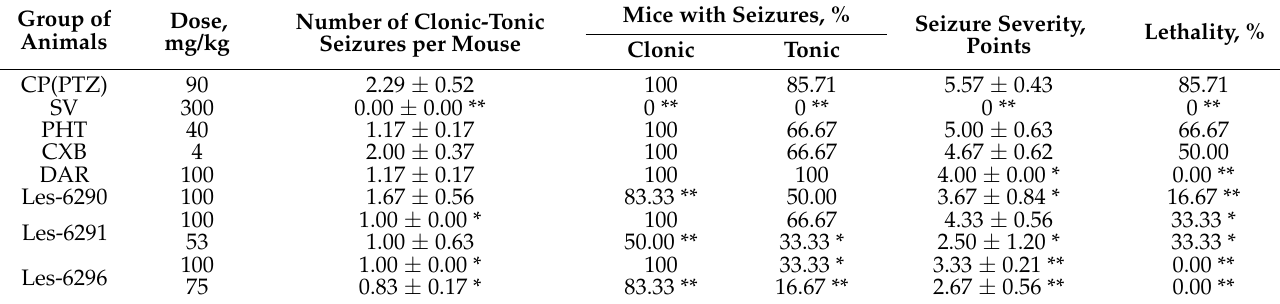
Table 2. Anticonvulsant activity of the reference drugs, celecoxib, dual COX-2/5-LOX inhibitor darbufelone methanesul- fonate and derivatives Les-6290, and Les-6291, Les-6296 in the scPTZ test. Each value represents the mean ± S.E.M. obtained from 6